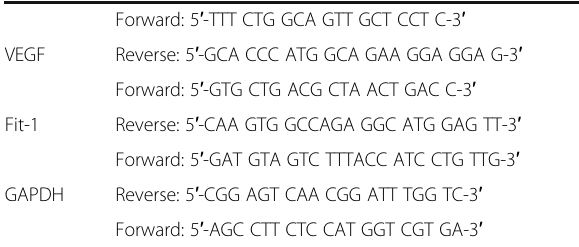
Table 1 Sequences of primers were used in this study